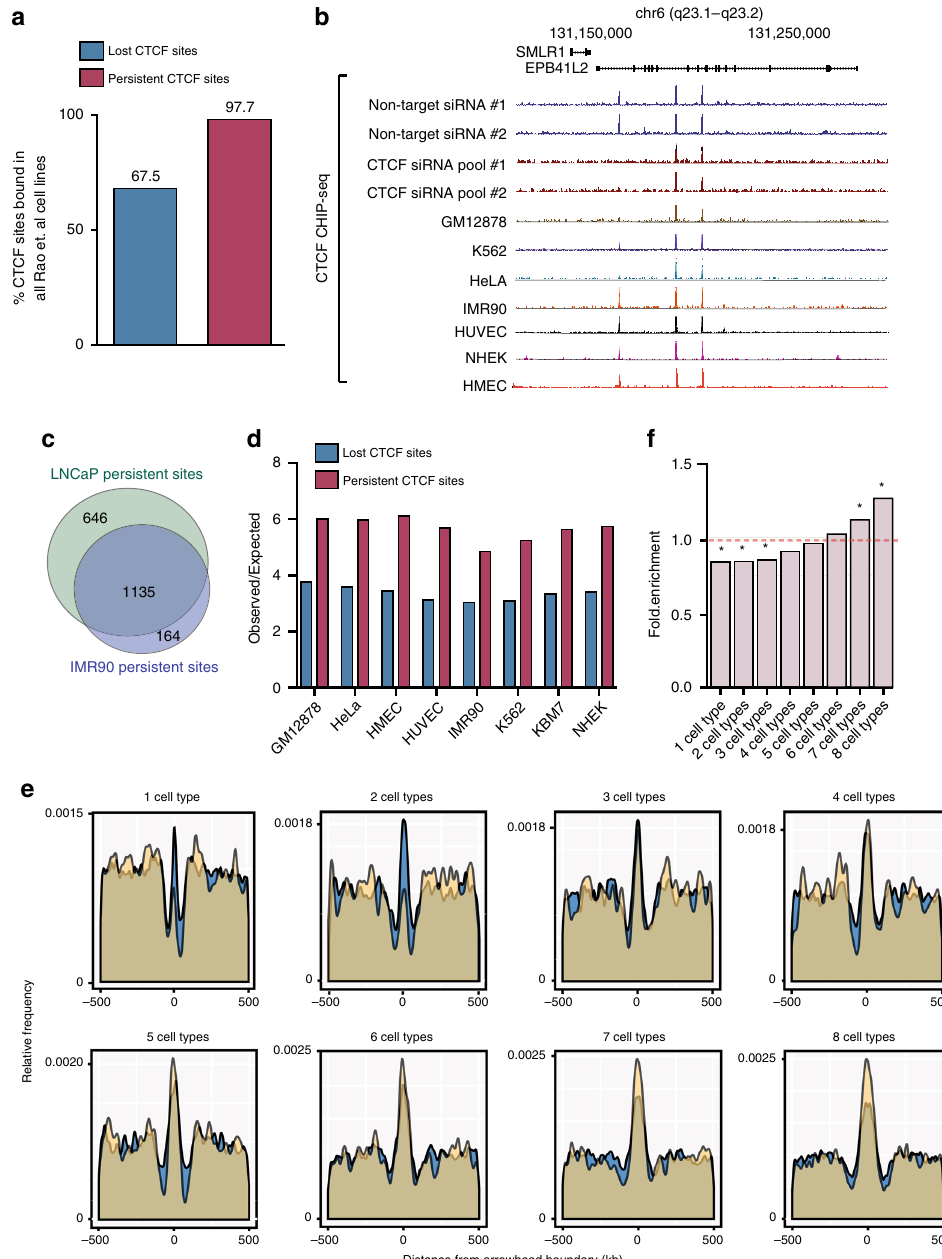
Fig. 7 Persistent sites are constitutively bound by CTCF in other cell types. a Bar graph shows greater proportion of persistent sites are constitutively bound by CTCF in GM12878, K562, HeLA, IMR90, HUVEC, NHEK and HMEC cell lines when compared to lost sites. b CTCF ChIP-seq data for replicate LNCaP RNAi experiments and wildtype GM12878, K562, HeLA, IMR90, HUVEC, NHEK and HMEC cells shows persistent sites are constitutively bound by CTCF in other cell types at an example locus. c Venn diagram illustrating overlaps of LNCaP-persistent sites with IMR90-persistent sites. d Graph showing observed/ expected ratio for lost (blue bars) and persistent sites (red bars) to overlap with domain boundaries in GM12878, K562, HeLA, IMR90, HUVEC, NHEK, HMEC and KBM7 cells. Comparing persistent to lost CTCF binding shows that persistent sites are more enriched to overlap domain boundaries. e Domain boundary data for GM12878, K562, HeLA, IMR90, HUVEC, NHEK, HMEC and KBM7 cells was subset based on whether each domain boundary was cell-type speci fi c (present in 1 cell line), common (present in 2 – 7 cell lines) or cell-type constitutive (present in all 8 cell lines). Positional enrichment of lost and persistent CTCF sites was plotted for each subset. Lost sites are enriched at cell-type-speci fi c domain boundaries. Persistent sites are enriched at cell-type constitutive domain boundaries (two-tailed t -test, * p = 0.02; n = 2 biologically independent experiments). f Enrichment of housekeeping genes at cell-type speci fi c, cell-type common and cell-type constitutive TAD boundaries from Rao et al. 4 (Hyper-geometric test, * p -value<0.05 after Bonferroni